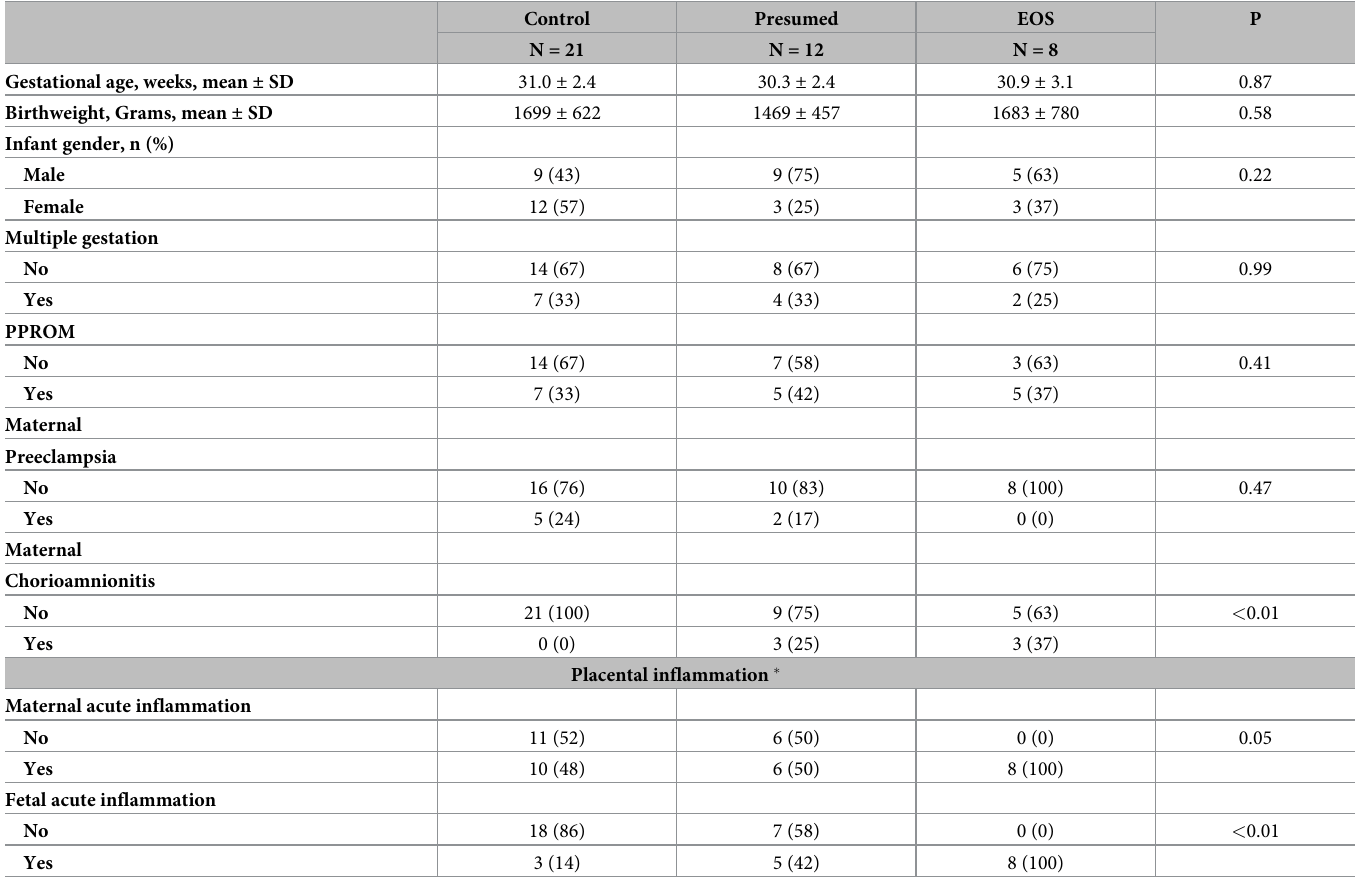
Table 1. Demographic and clinical characteristics of the study groups. Control Presumed